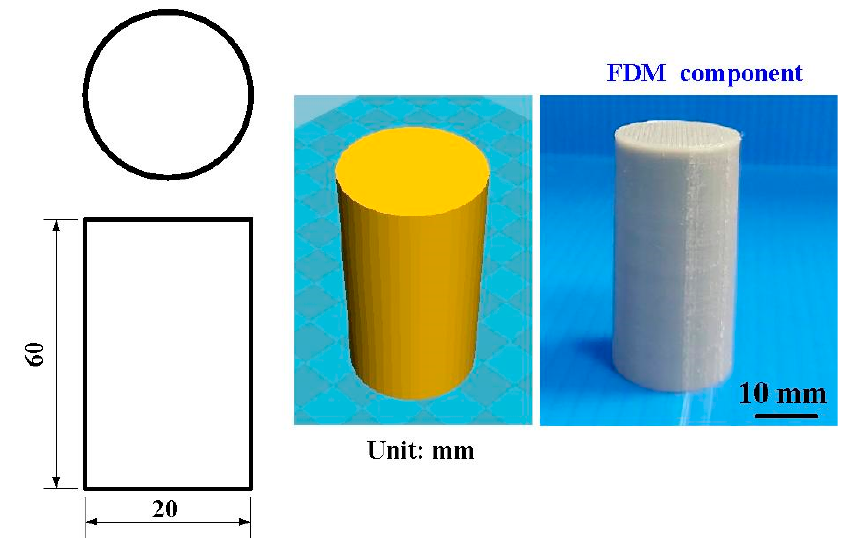
Figure 2. CAD model and dimensions of FRW specimen.